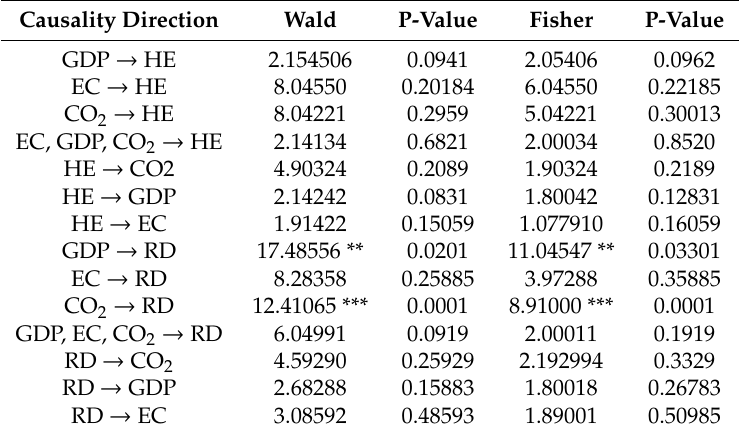
Table 9. Short-term Causality